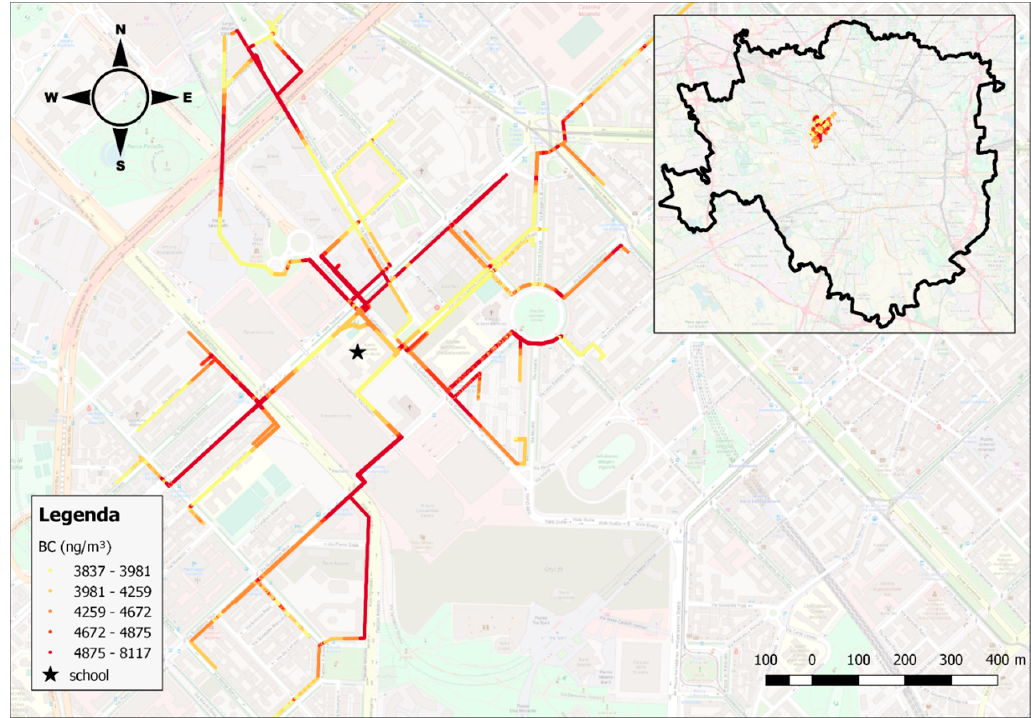
Figure 5. Study area and home-to-school routes. The lines were converted to equidistant points, located at 1-m distance from each other. For each point, Equation (2) was applied to estimate BC concentrations. The colors are associated to the quantile of all estimates. The inset map represents the Municipality of Milan boundaries (black line) as well as the study area (yellow-to-red lines).